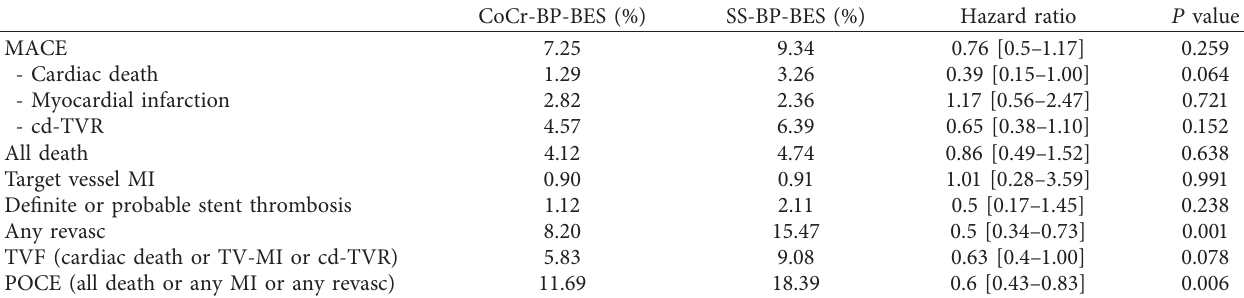
Table 3: Biomatrix Alpha versus LEADERS : propensity-adjusted MACE at 2 years with a landmark at day